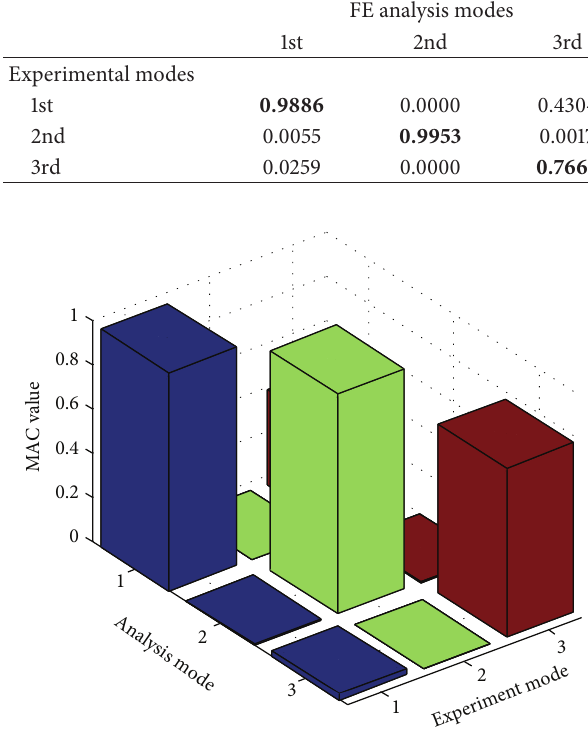
Figure 8: MAC plot (7 DOF anal. and exp.).